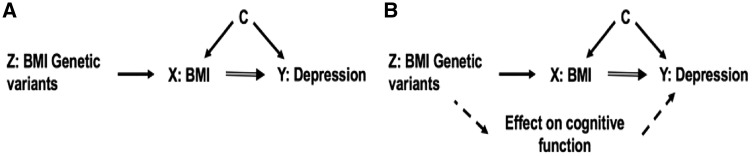
The principles of Mendelian randomization and key MR assumptions which are: (i) the genetic instrument (Z) is robustly related to the risk factor of interest (X); (ii) Z is not associated with confounders (C) of the X-outcome (Y) association; and (iii) there is no path from Z to Y other than through X (part a). Part b shows how this may be violated.